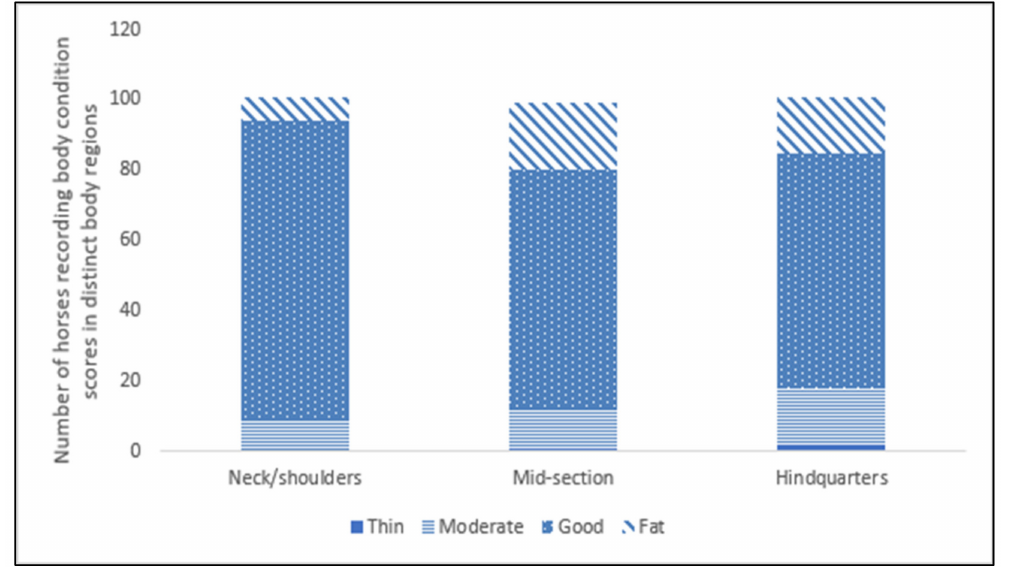
Figure 1. Number of horses ( n = 101) recording body condition scores on distinct body regions (Scale 0 = very thin, 1 = thin, 2 = moderate, 3 = good, 4 = fat, 5 = very fat, Carroll and Huntington, [27]). Hair coat condition: The majority (76%, n = 79) of horses had a healthy/sleek and glossy hair coat condition while only around 8% ( n = 8) had an unhealthy/dry/dull coat. A muddy coat from negative environmental conditions was assessed on 8.7% ( n = 9) of horses, and 7.7% ( n = 8) of horses were assessed with a muddy coat from positive activities such as